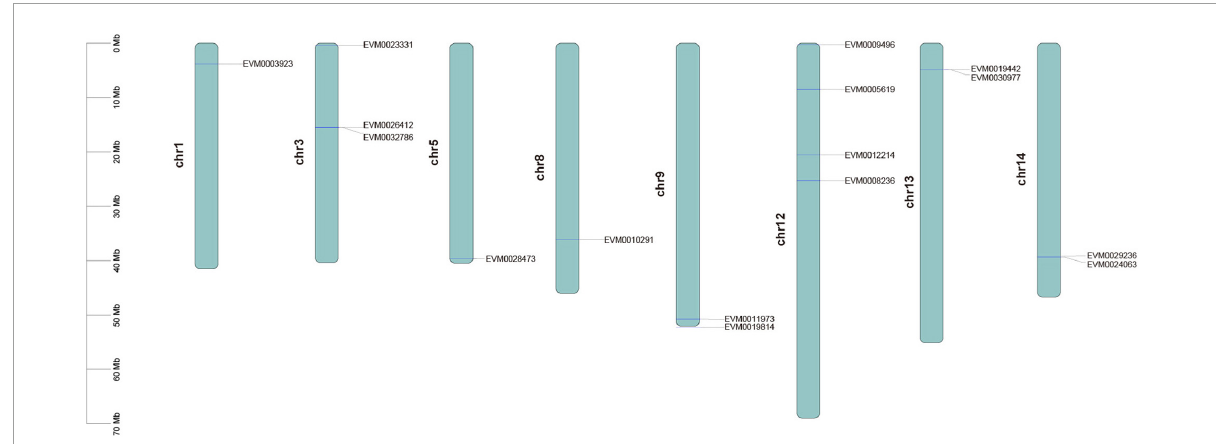
FIGURE1 Distribution location of CCD gene family in the Forsythia suspensa genome.